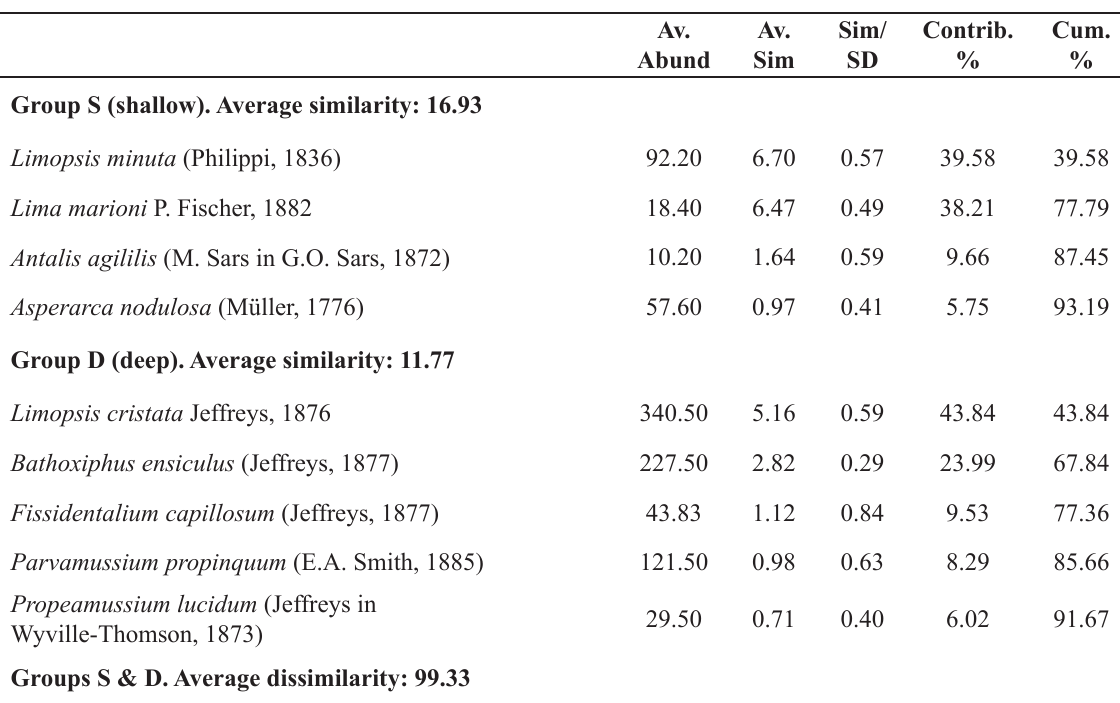
Table 3. Contribution of the species to the similarity between samples.